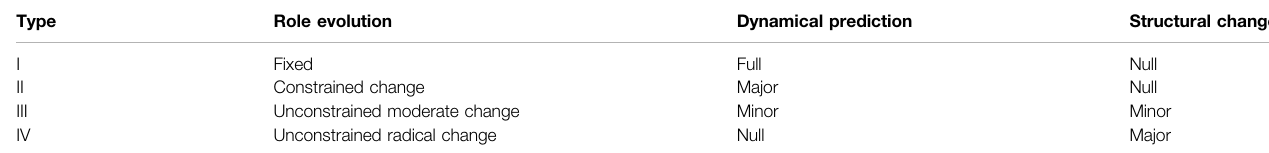
TABLE 1 | Summarizing types of emergent properties in terms of both role modi fi cations of the entities forming the system and